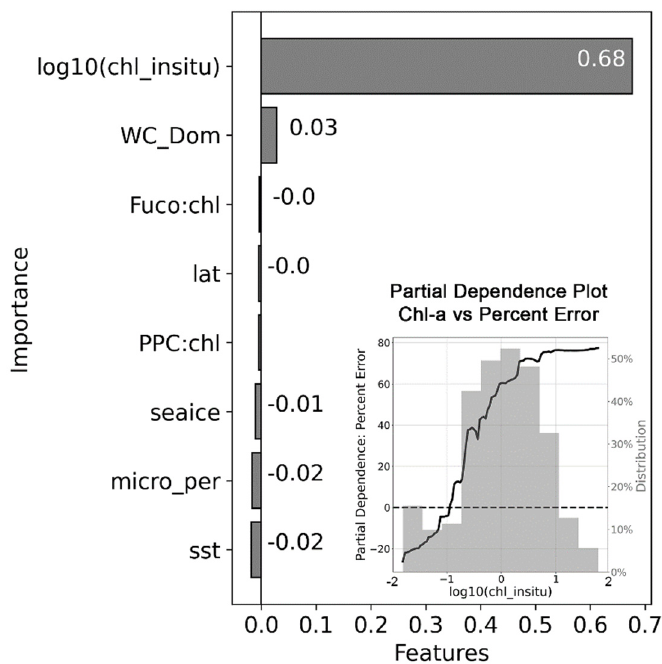
Figure 7. Results from the random forest analysis. Drop-column importance (i.e., how much each feature contributes to the out-of-bag error, a measure of accuracy of the model; the higher the out-of-bag error, the more accurate the predictions of the model) for each variable used in the model: Chl- a in log 10 scale (chl_insitu), dominant water optical class (WC_Dom), Fuco:Chl -a, PPC:Chl- a , latitude (lat), sea ice presence, percentage of microphytoplankton (micro_per) and SST. The inset contains the partial dependence plot for the in-situ Chl -a concentration (i.e., the relationship predicted by the model between in-situ Chl -a and the percent error).